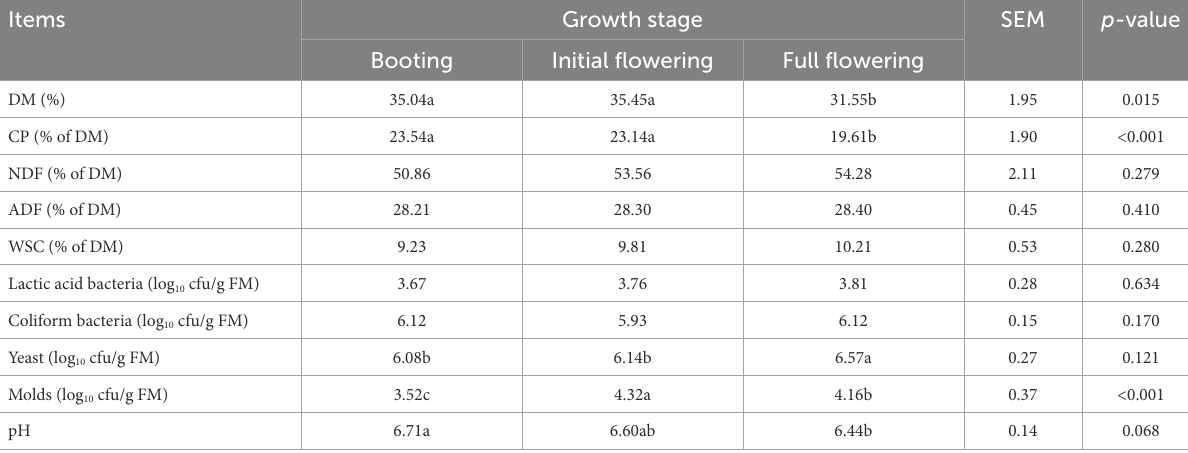
TABLE 1 Chemical and microbial compositions of fresh